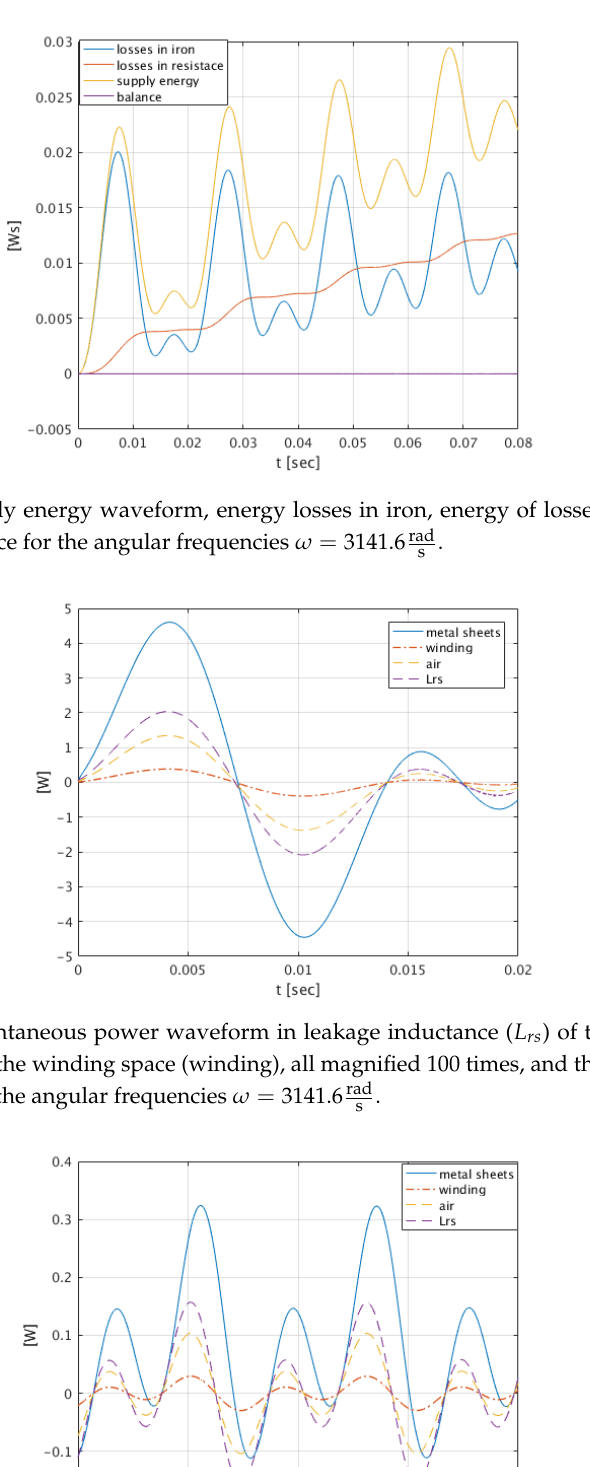
Figure 15. The instantaneous power waveform in leakage inductance ( L rs ), in air space (pow), winding space power (uzw), all magnified 100 times, and the power of losses in laminated sheets for the angular frequencies ω = 3141.6 rad s